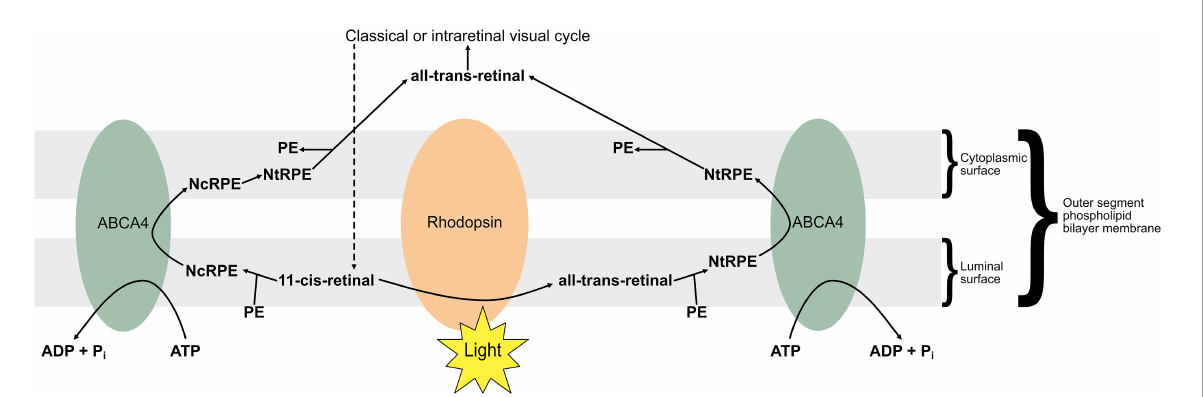
FIGURE4 The “flipping” function of ABCA4. 11-cis retinal accumulates in darker conditions as opsins are saturated, whereas all-trans retinal is produced by photoisomerisation in lighter conditions. Retinal associates with membranal phosphatidylethanolamine (PE) to form N-cis-retinylidene-PE (NcRPE) and N-trans-retinylidene-PE (NtRPE), which ABCA4 flips across the membrane at the cost of ATP hydrolysis. NcRPE and NtRPE dissociate, and 11-cis retinal undergoes chemical isomerisation, allowing all-trans retinal to reenter the visual